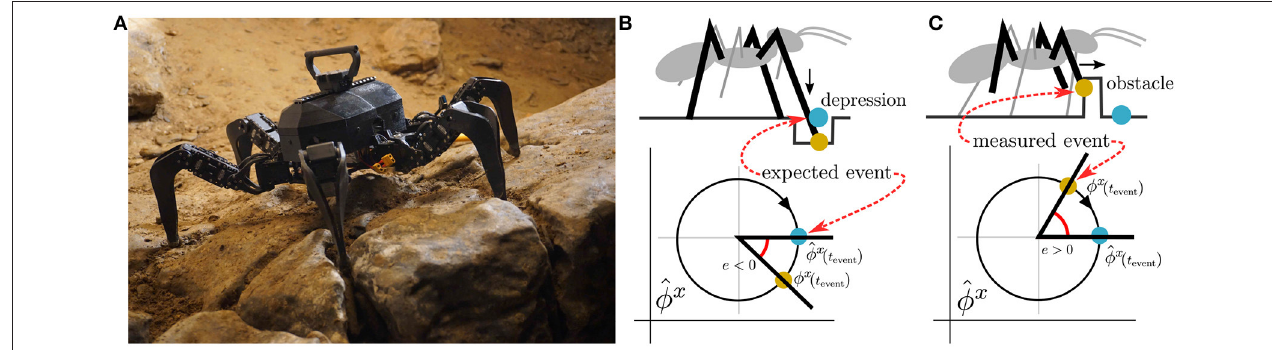
FIGURE 1 | (A) The utilized hexapod walking robot in Bull Rock cave. The unstructured environment causes motion disturbances, which result in sensory event mistiming. The sensory phase φ x measurement is compared to its estimation ˆ φ x , where their difference is the phase error e . We distinguish two types of phase error: event absence, φ x > ˆ φ x , and disruption, φ x < ˆ φ x . An example of event absence is illustrated in (B) , where at the beginning of the stance phase, the front leg finds itself in a depression (orange dot) and thus detects the ground contact later than expected (blue dot). In the disruption example (C) , at the end of the swing phase, the front leg hits elevated terrain (orange dot) and thus detects the ground contact sooner than expected (blue